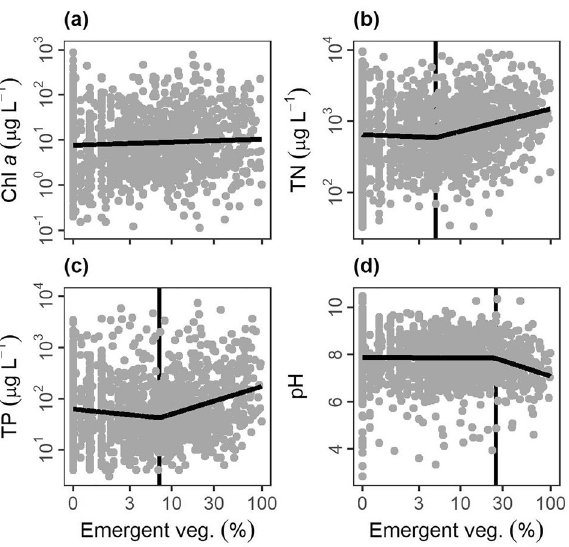
Figure 7. Relationships between lentic waterbody emergent vegetation cover (Emergent veg.) and various ecosystem structure and function metrics: ( a ) chlorophyll a concentrations (Chl a ), ( b ) total nitrogen concentrations (TN), ( c ) total phosphorus concentrations (TP), ( d ) pH from literature data extraction with optimal model fits from null, linear or null, segmented linear, and logistic curves in bold foreground lines. For nonlinear segmented and logistic models ( b – d ), plots are ordered by model breakpoints or inflection points (vertical background lines), indicative of boundaries between ponds and wetlands.